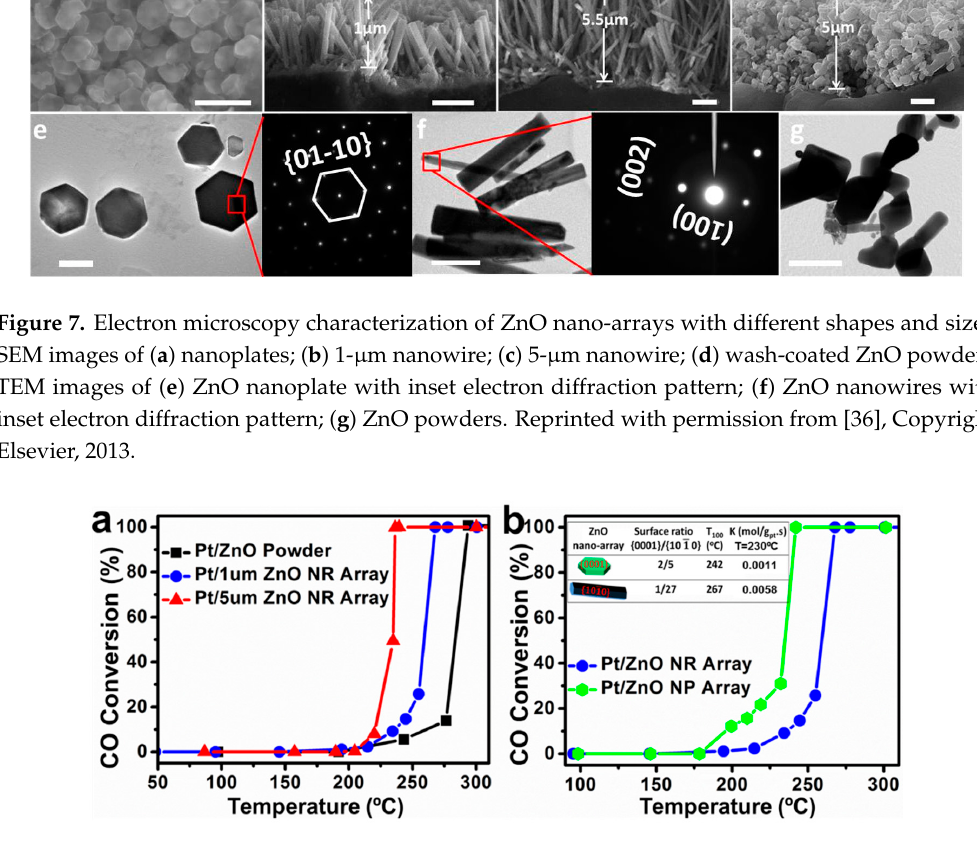
Figure 8. Catalytic CO oxidation performance of Pt loaded on ZnO nano-arrays with different lengths and shapes. ( a ) CO oxidation conversion as a function of temperature over 1 µ m and 5 µ m long Pt-loaded ZnO nanorod array and washcoated Pt/ZnO powder catalysts. ( b ) CO oxidation conversion as a function of temperature over Pt-ZnO nanorod array and Pt-ZnO nanoplate array. Reprinted with permission from [36], Copyright Elsevier,